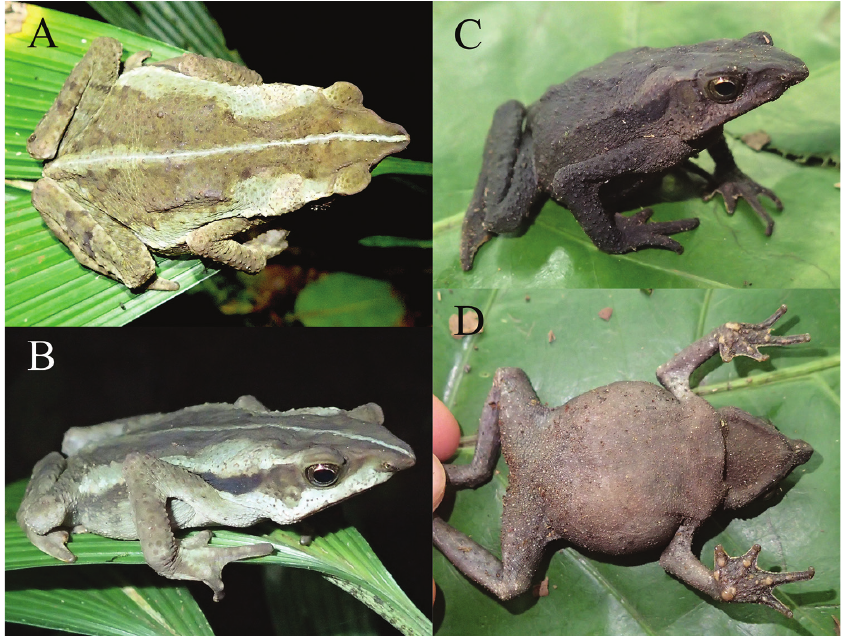
Figure 7. Paratype of Rhinella lilyrodriguezae sp. n. (MUSM 32201, SVL = 57.5 mm) in life. A Dorsal and B laterodorsal views of the coloration at night C Laterodorsal and D ventral views of the coloration during the day. Photos by K. Tasker. Table 2. Morphometric measurements in mm of the holotype and paratypes of Rhinella lilyrodriguezae sp. n. See text for